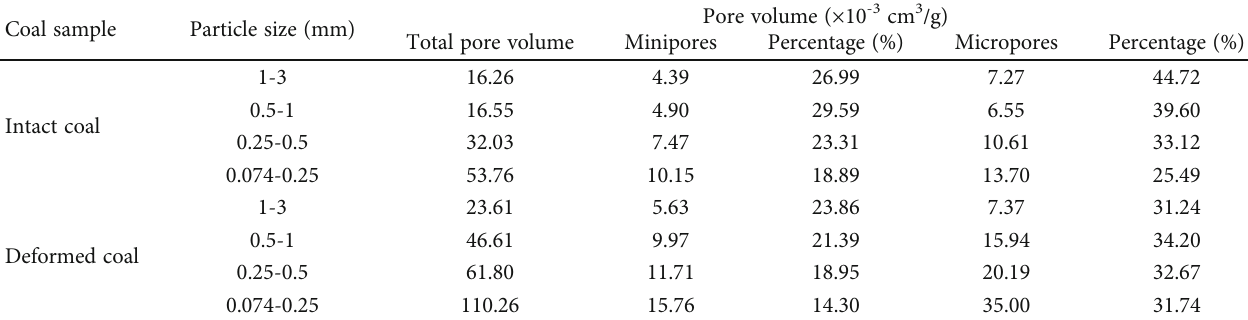
Table 3: Pore structure characteristic parameters of minipores and